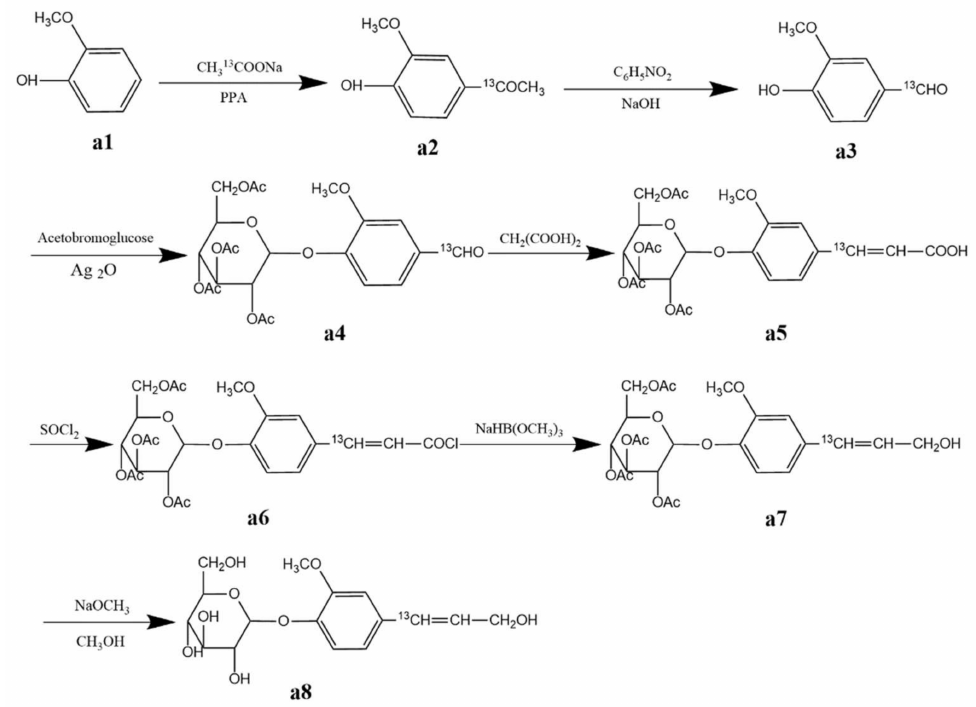
Figure 12. Synthesis of coniferin-[ α - 13